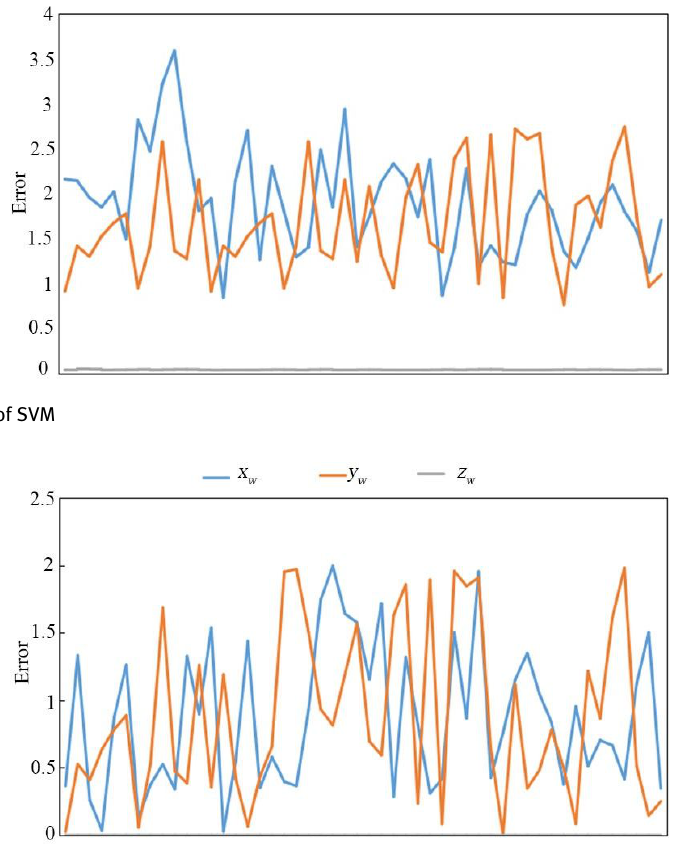
Figure 5: Error changes of